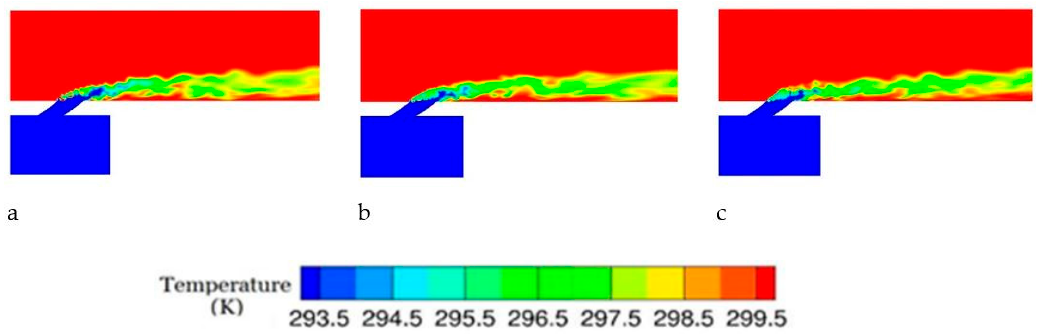
Figure 35. ( a ) The instantaneous temperature contour at the central cross section obtained using FLUENT, LES, Smagorinsky–Lilly model for M = 1.0, 1072 Hz. ( b ) The instantaneous temperature contour for the central cross section obtained using FLUENT, LES, Smagorinsky–Lilly model for M = 1.0, 1608 Hz. ( c ) The instantaneous temperature contour for the central cross section obtained using FLUENT, LES, Smagorinsky–Lilly model for M = 1.0, 2144 Hz.